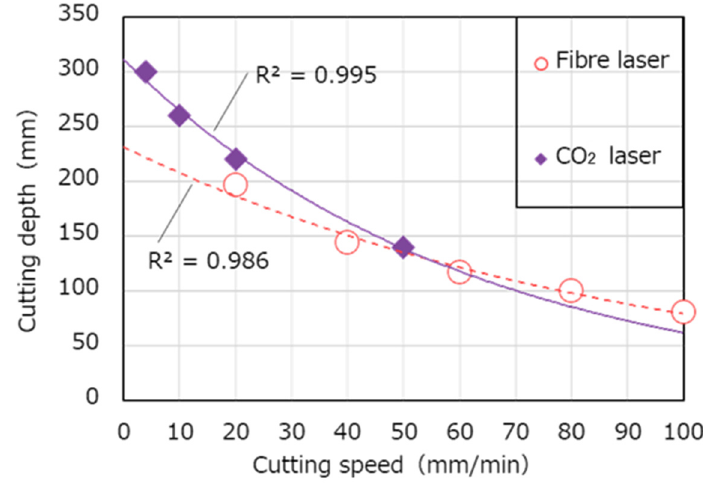
Figure 11. Cutting depth curves of the CO 2 and fibre lasers (laser 9 kW).